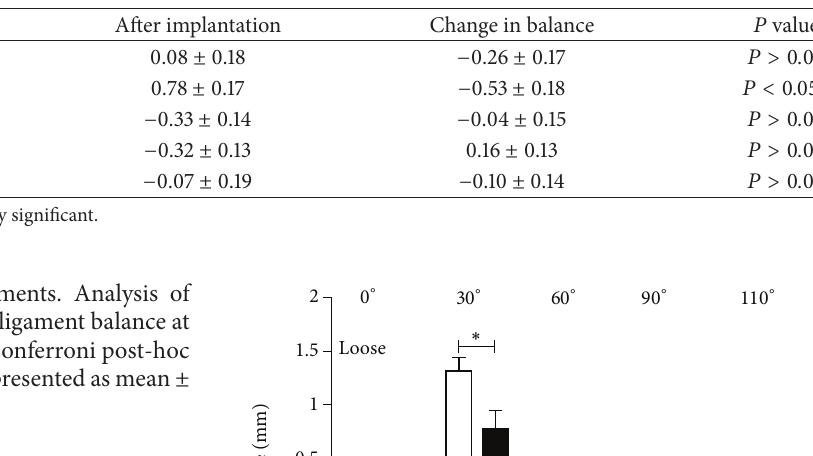
Table 1: Comparison of the intra-operative balance plan and ligament balance measurements following component implantation. Data is expressed as mean ± standard error of the mean in millimeters.